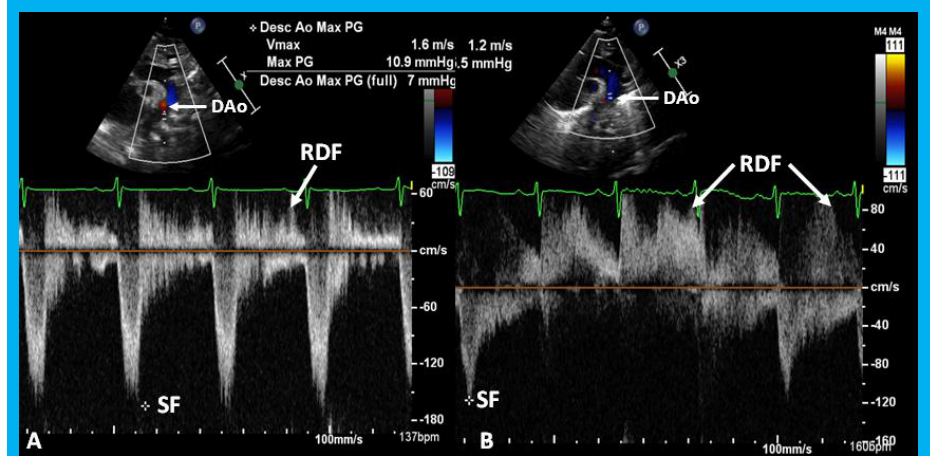
Figure 34. ( A ) Echocardiographic frame from a suprasternal notch view illustrating laminar flow in the descending aorta (DAo) in a premature infant with a small ductus (not shown). ( B ) Continuous wave Doppler recording in the same infant shows normal systolic flow (SF) (*) and normal anterograde diastolic flow (ADF) in the DAo; the diastolic flow is seen below the baseline.